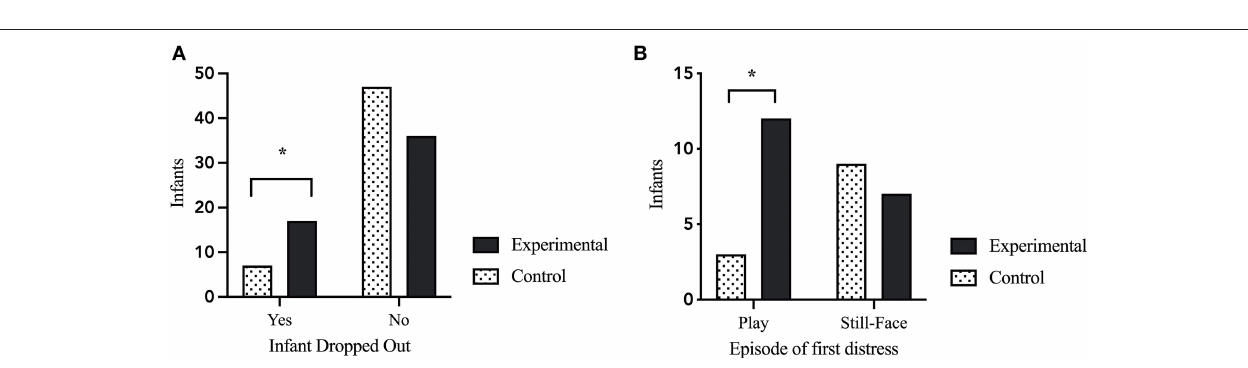
FIGURE 2 | Infant behavioral stress reactivity. (A) Infant drop-out of the paradigm due to exhibition of distress crying for 30-consecutive-seconds. Infants in the maternal stress condition had to terminate the procedure significant more often than infants in the control condition [ X 2 = (1, N = 106) = 4.662, p = 0.031]. (B) Episode of first distress in the infants during the CASP paradigm. Infants in the maternal stress condition showed first distress significantly more often in the play episode after the caretaker-stress (or control) manipulation compared to infants of the maternal control condition [ X 2 = (1, N = 31) = 4.288, p = 0.038). p <